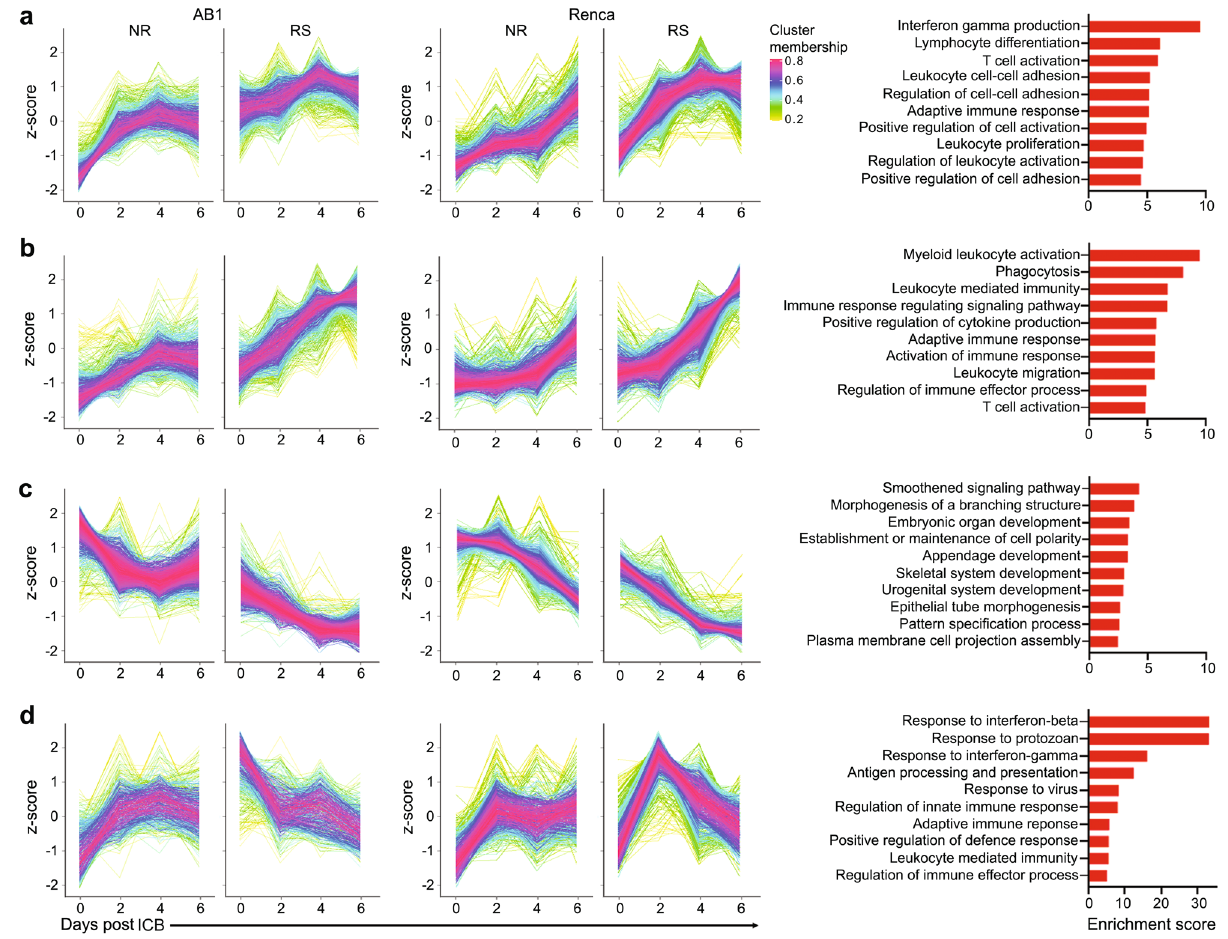
Fig. 2 | Responders and non-responders have similar reactions to ICB, but respondersshutoffgenesrelatedtoIFN β signalling. TCseqanalysiswasusedto clustergeneswithsimilarexpressionovertime,identifyingclusterssharedbyboth AB1 and Renca. Gene expression over time and pathway analysis of overlapping